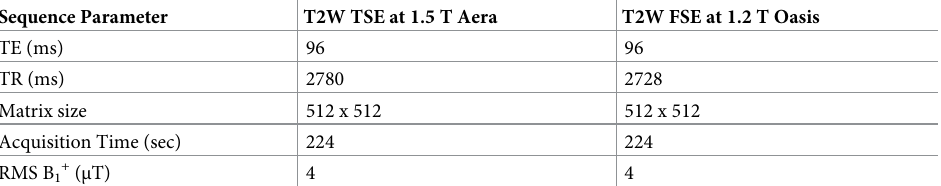
Table 1. MRI pulse